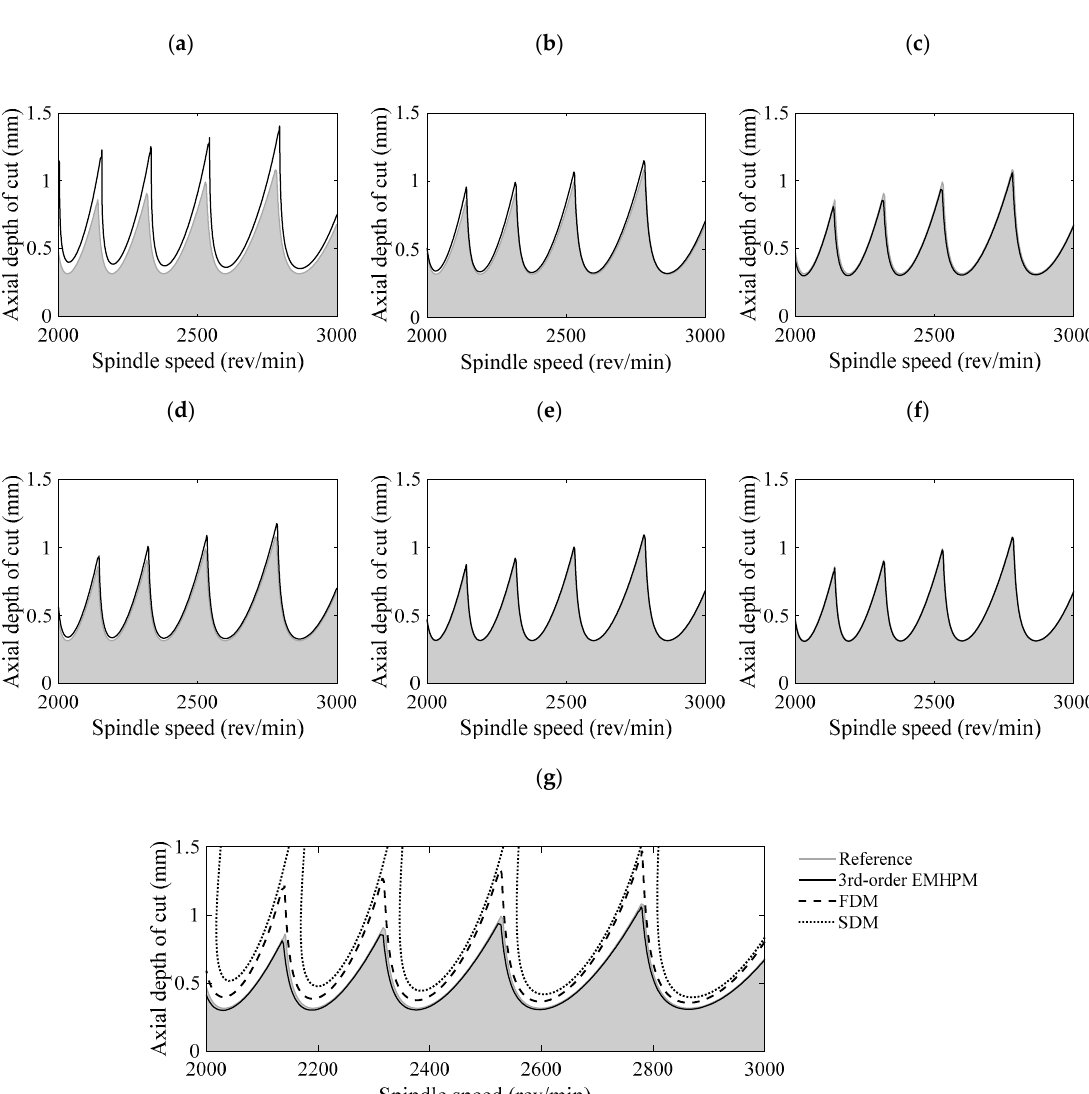
Figure 4. Stability diagrams for down-milling operation. The first ( a – c ) and second ( d – f ) rows of subfigures correspond to N = 60 and N = 100 discrete intervals, respectively. First ( a , d ), second ( b , e ) and third ( c , f ) columns correspond to the first-, second- and third-order EMHPM, respectively. Subfigure ( g ) shows a comparison between the third-order EMHPM (black line), the SDM (dot line) and the FDM (dash line) with N = 60 discrete intervals.